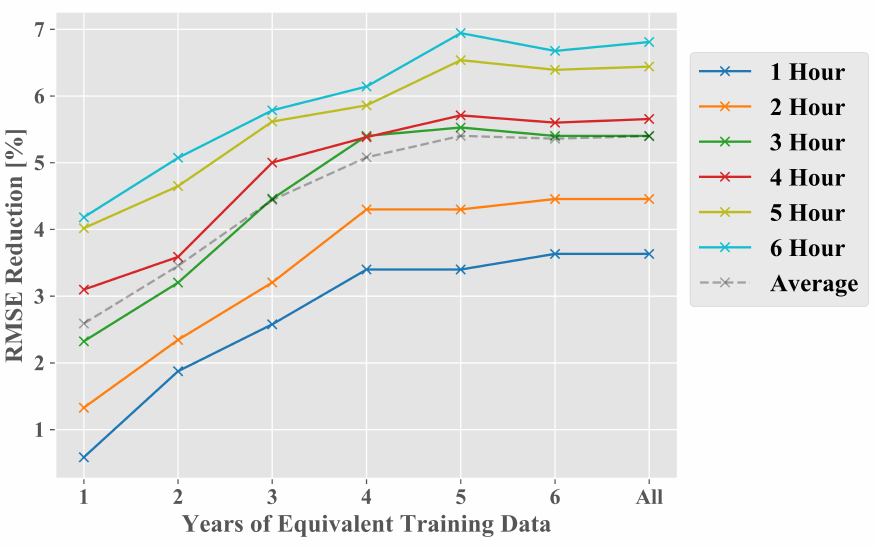
Figure 6. Reduction in RMSE obtained by the DE modeling strategy compared to the persistence model based on the amount of training data available at the FINO1 site. Solid colored lines indicate the number of hours in advance for forecasting, while the dashed gray line indicates the average of all colored